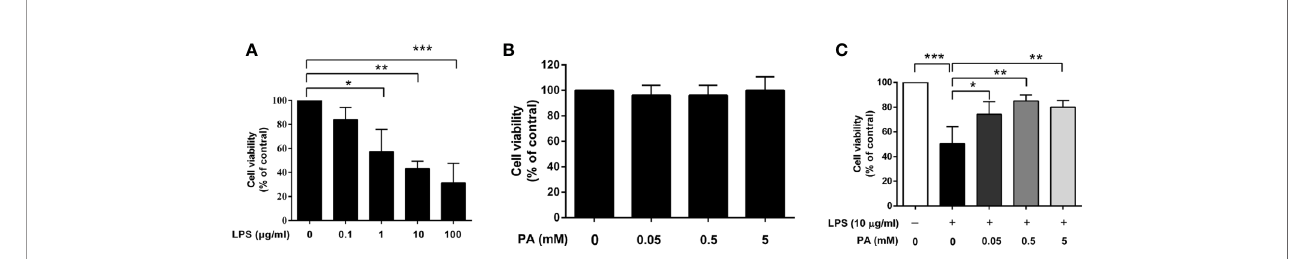
FIGURE 1 | The effects of LPS and PA on IEC-6 cells ’ viability. Cell viabilities were assayed by the MTT method. (A) IEC-6 cells were stimulated with different concentrations of LPS (0, 0.1, 1, 10, and 100 m g/ml) for 24 h. (B) IEC-6 cells were treated with PA at a series of concentrations (0, 0.05, 0.5, and 5 mM) for 24 h. (C) IEC-6 cells were treated with PA (0, 0.05, 0.5, and 5 mM) and LPS (l0 m g/ml) for 24 h. The data represent the averages ± S.D. Signi fi cant differences between the treatment and control groups are indicated as *P < 0.05, **P < 0.01, ***P < 0.001. Signi fi cance was determined by